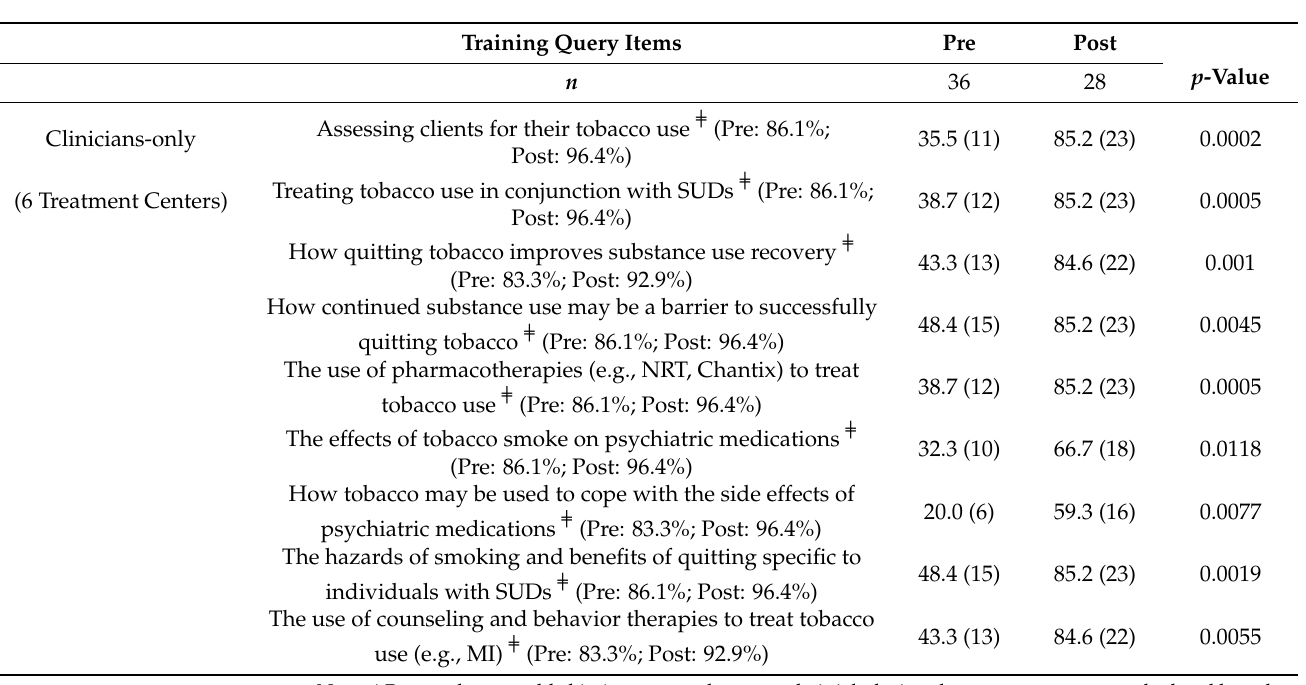
Table 2. Training receipt from pre- to post-implementation among responding employees and cli- nicians in opioid addiction treatment centers. ‡ Training Query Items